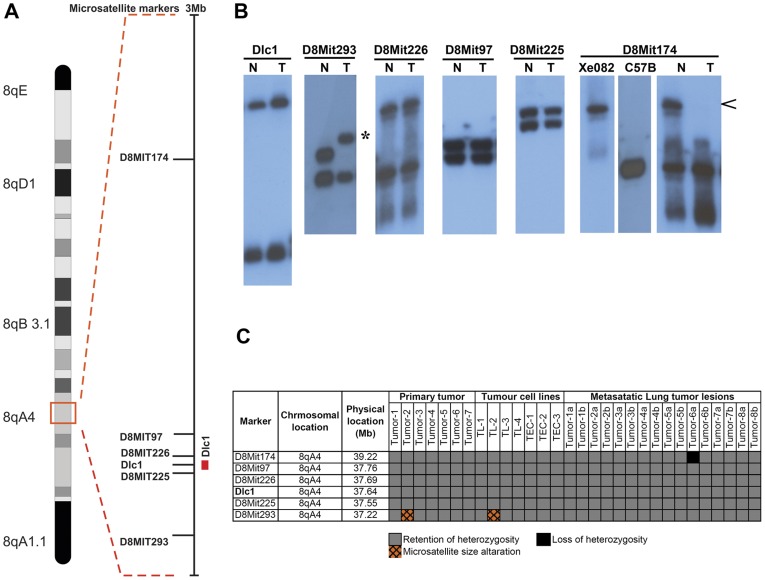
Deletion mapping of Dlc1 locus.(A) Diagrammatic representation of the relative position of the different microsattelite markers used for loss of heterozygosity analysis. (B) Representative autoradiographs showing the alleles specific to the different microsatellite markers. Arrow indicates LOH of one allele and the asterisk indicates microsatellite size alteration (MA) of one allele, N-Normal, T-Tumour (C) Allele status of the chromosome 8qA4 markers in the thymic tumours and TEC and TL cell lines as well as corresponding primary and metastatic tumours; RH - Retention of homozygosity. Tumours 1–7 are primary thymic tumours corresponding to TL and TEC cell lines. The subcategory a and b under Tumour 1–7 represents DNA obtained from two independent lung metastatic lesions of the corresponding primary tumour respectively.